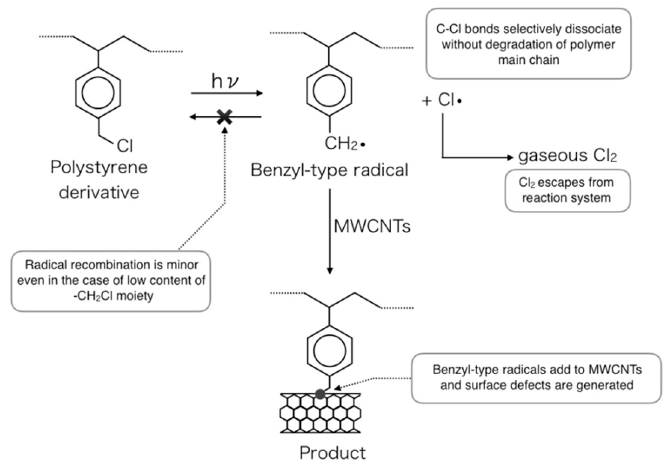
Figure 5. Schematic illustration of the chemical modification of multi-walled carbon nanotubes with polymer side chain radicals.